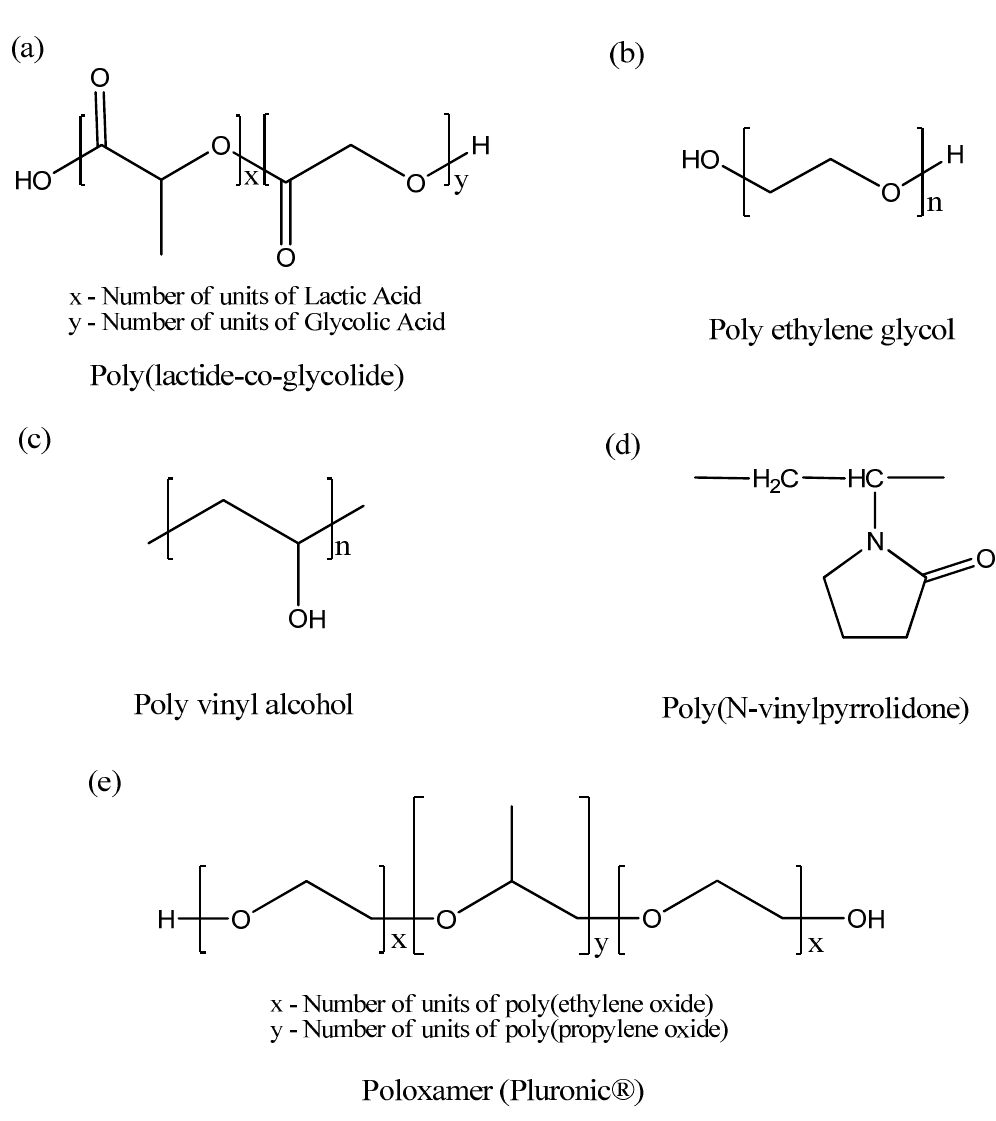
Figure 1. Structures of biodegradable and biocompatible